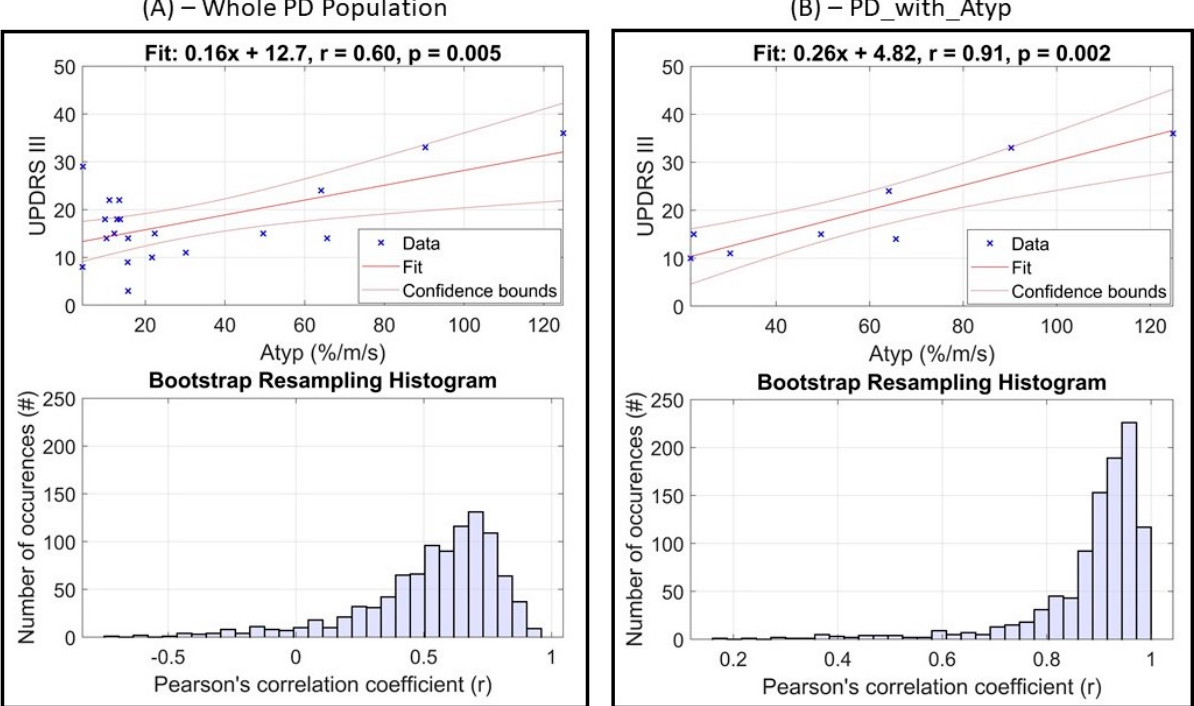
Figure 6. Correlation analysis between the normalized percentage of atypical gait cycles (for the more-affected side of PD patients) and UPDRS-III computed for: ( A ) the whole PD group, and ( B ) the 𝑃𝐷_𝑤𝑖𝑡ℎ_𝐴𝑡𝑦𝑝 subgroup.